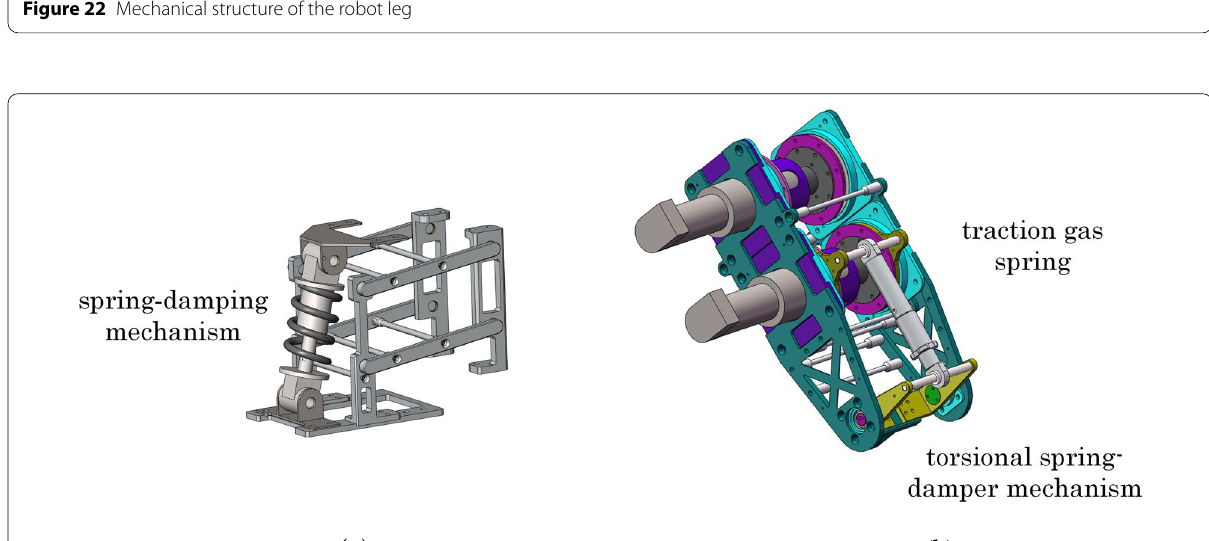
Figure 22 Mechanical structure of the robot leg